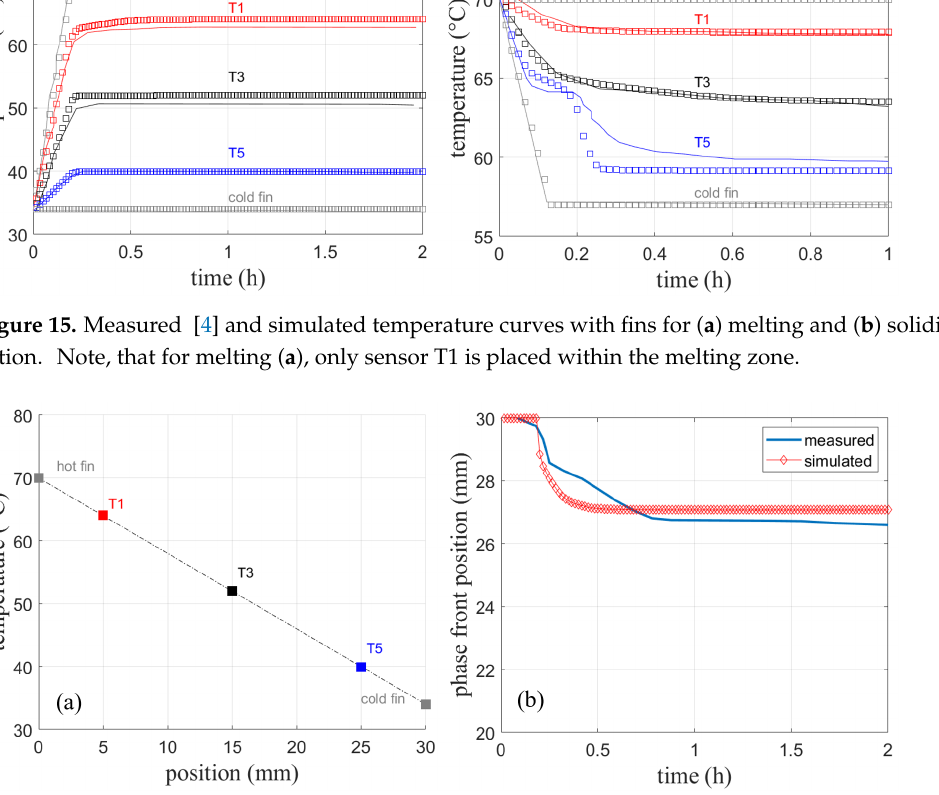
Figure 16. ( a ) Temperatures of the sensors at t = 2 h reveal a linear temperature profile. ( b ) Simulated phase front position compared to the measured position from